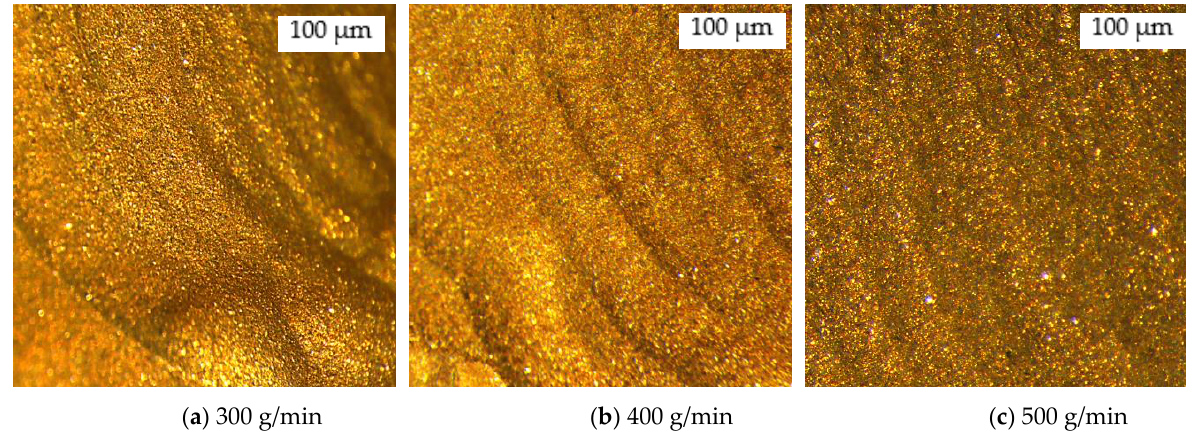
Figure 12. Topography of AISI 304L cut surface with 12 mm thickness using varied Abrasive mass flow rate.